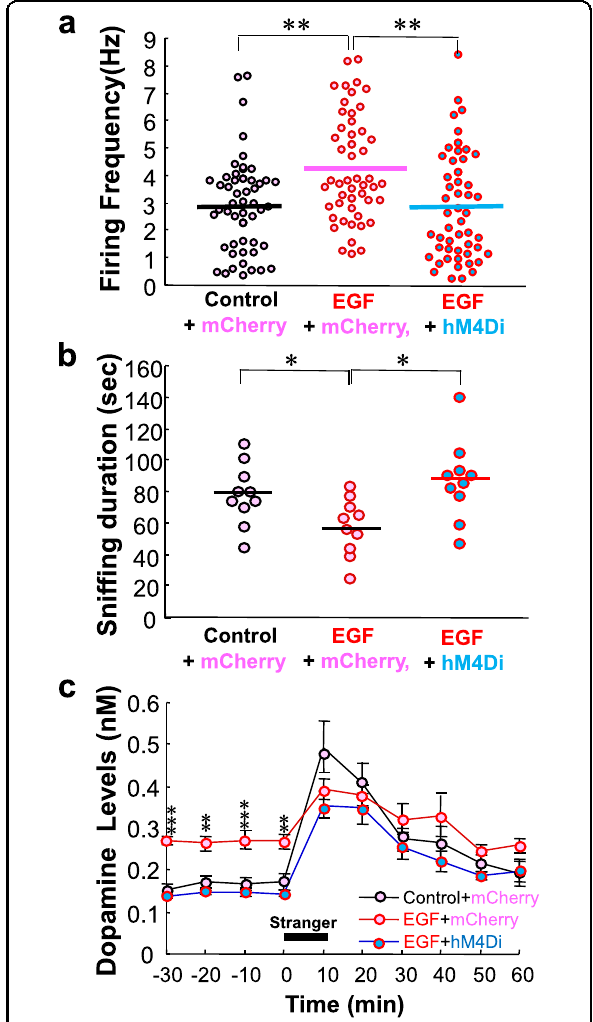
Fig. 4 DREADD-driven attenuation of hyperdopaminergic states ameliorates social interaction de fi cits of epidermal growth factor model rats. a AAV vectors carrying the hM4Di gene plus mCherry (hM4Di) or mCherry alone (mCherry) were microinjected into the VTA of EGF model rats or control rats. The hM4Di ligand clozapine N-oxide (CNO) was subchronically administered to these rats with the aid of an osmotic pump. The DREADD effects on fi ring rates of